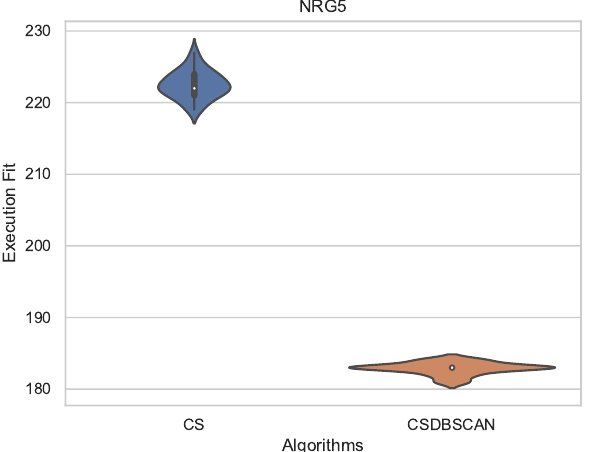
Figure 13. Instance NRG.5 distribution.